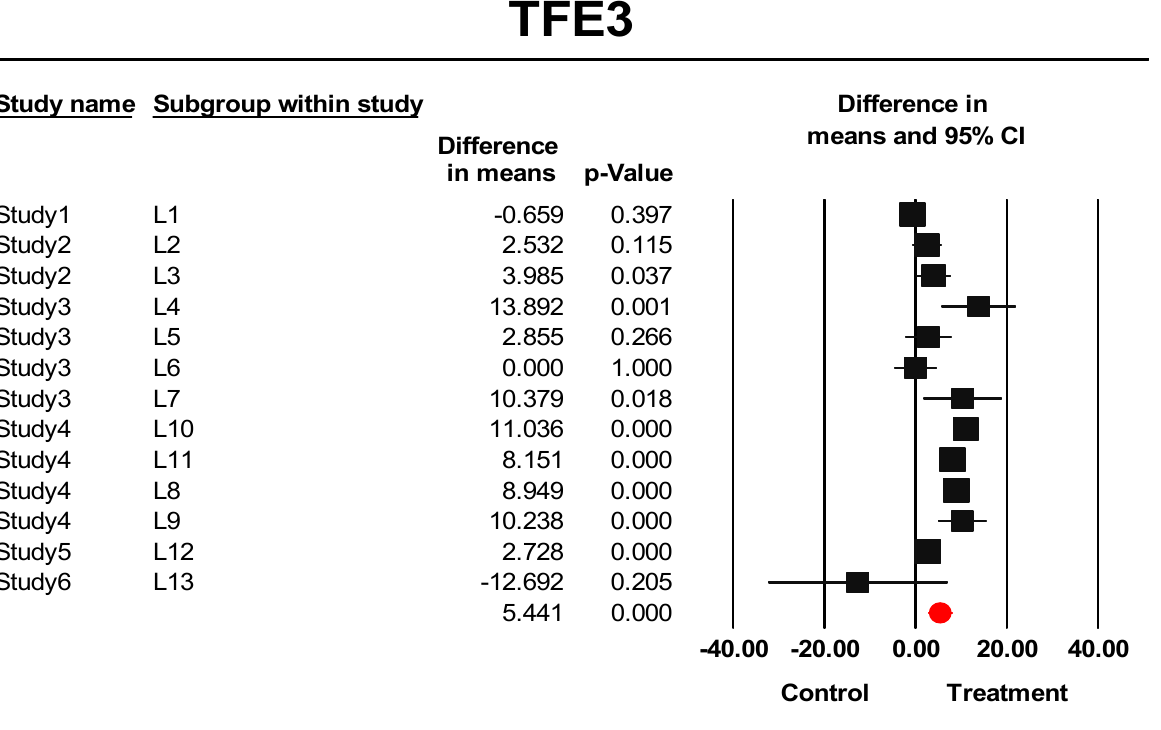
Figure 7. RPKM meta-analysis of thirteen datasets for overall expression of TFE3 in treated and control groups. The black square shows the mean difference of treated and control RPKMs for each study. The red circle shows the summary of the overall effect size across all studies. The effect size direction is higher than zero if the expression is higher in treated samples. Table 4. Differentially expression of AIP, VGLL4, TFE3, and ID1 in response to genistein in HepG2 cell Table 3. Prediction bias indices for each signature TFs.